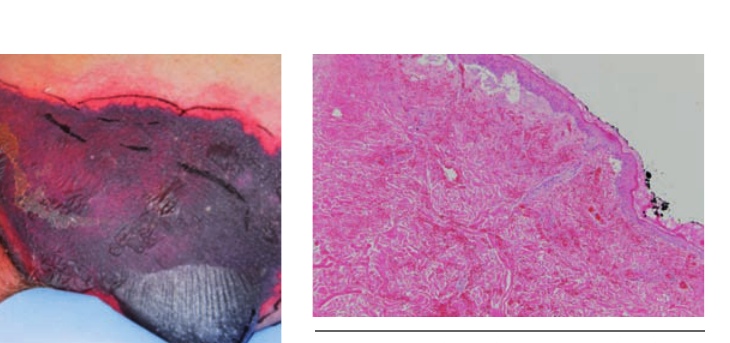
Figure 4. Epidermal necrosis with sub epi- dermal bullous formation and